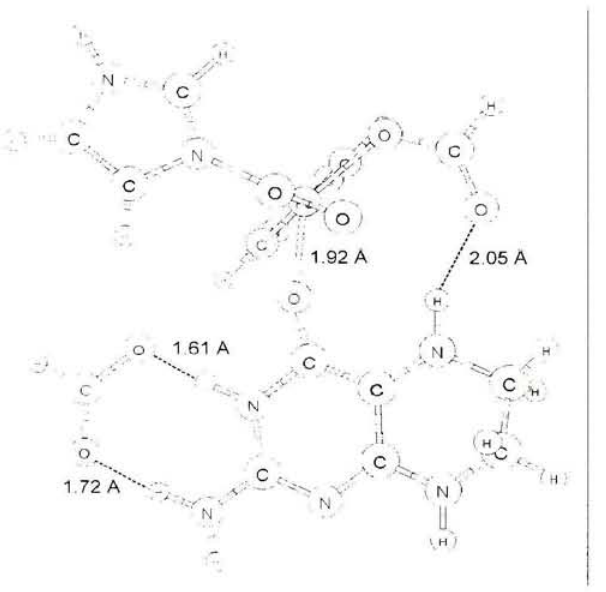
Figure 2. Top view of the septet ground state of the iron-dioxygen complex as optimized using DFT. The dioxygen molecule is seen in front of the iron atom. The O-O distance of dioxygen is 1.35 A in the com-